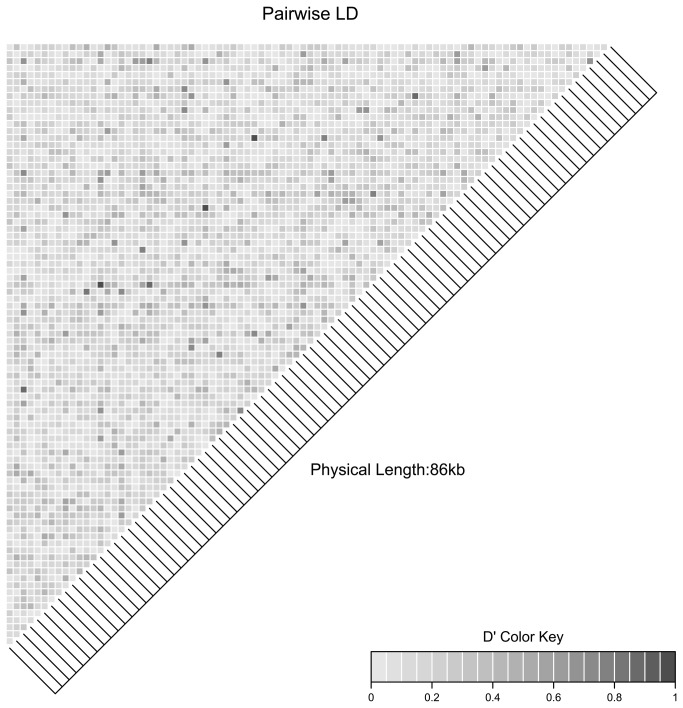
Linkage Disequilibrium Heatmap.Pair-wise linkage disequilibrium (D’) for autosomal SNPs (n=87) with unrelated individuals (n=50).